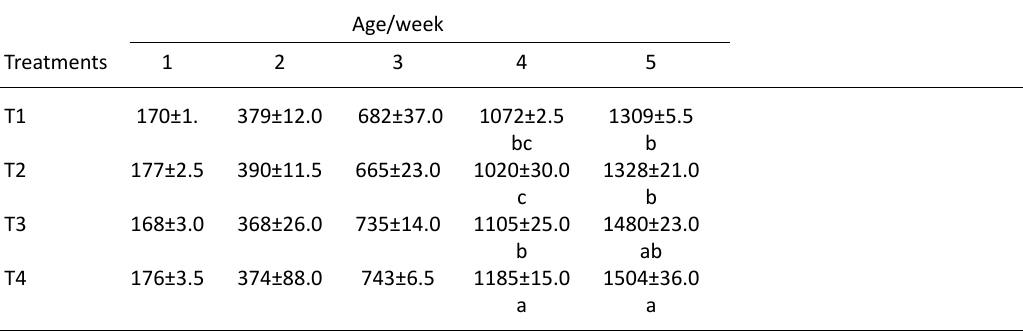
Table 2. Effect of fermented maize by S.cerevisiae in diets on the live body weight (g) of broiler chicks for 5 weeks. Age/week